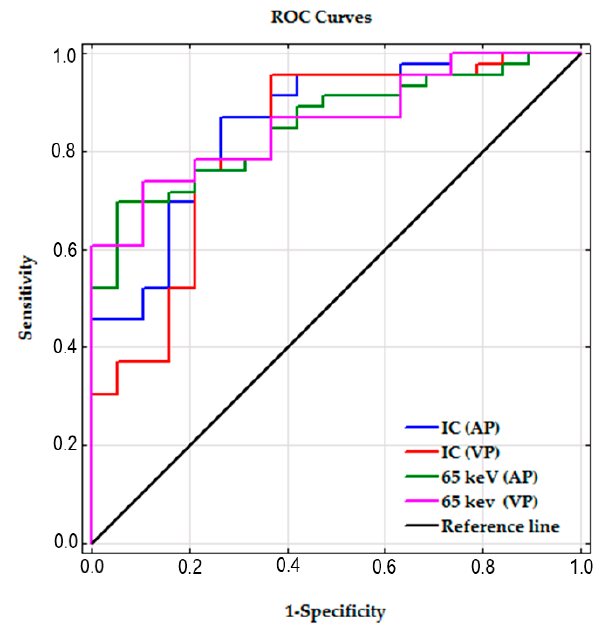
Figure 6. ROC curves of all the parameters used to differentiate the malignant and benign